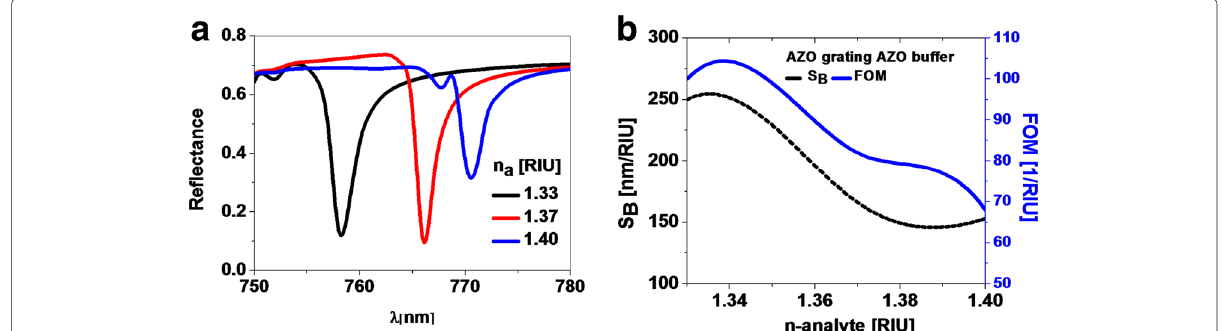
Fig. 3 a Spectral reflectance for an optimum design that uses AZO as the buffer layer as a function of the index of refraction of the medium under test. The sharpness of the resonance peak degrades as the index of refraction increases. b Sensitivity (left axis and black dashed line) and figure of merit (right axis and blue solid line) as a function of the index of refraction of the medium under